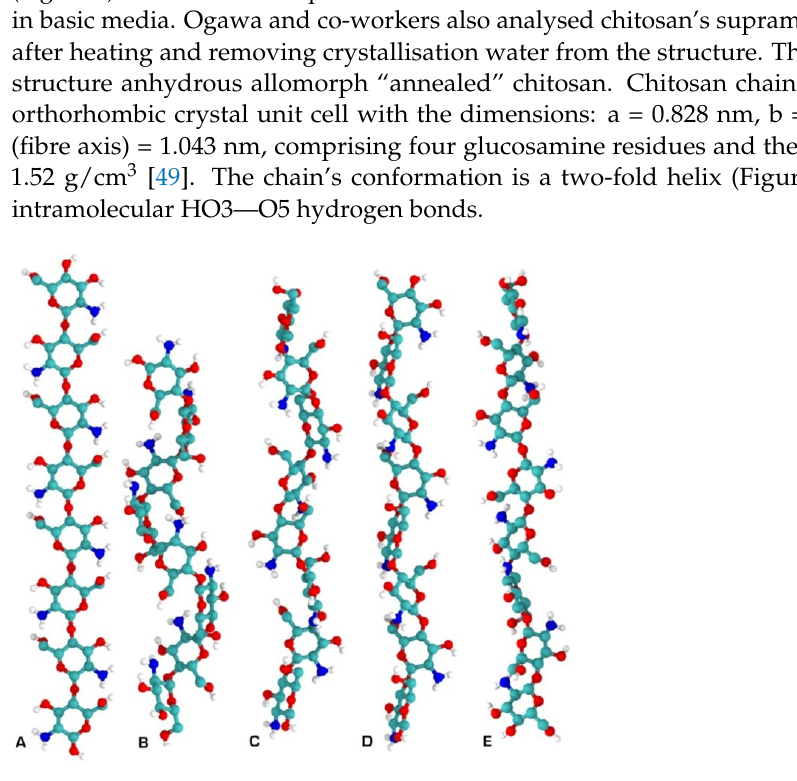
Figure 5. Chitosan secondary structures as determined by solid X-ray crystallography. ( A ) Two-fold; ( B ) three-fold; ( C ) four-fold; ( D ) five-fold; ( E ) two-relaxed-fold [40] .